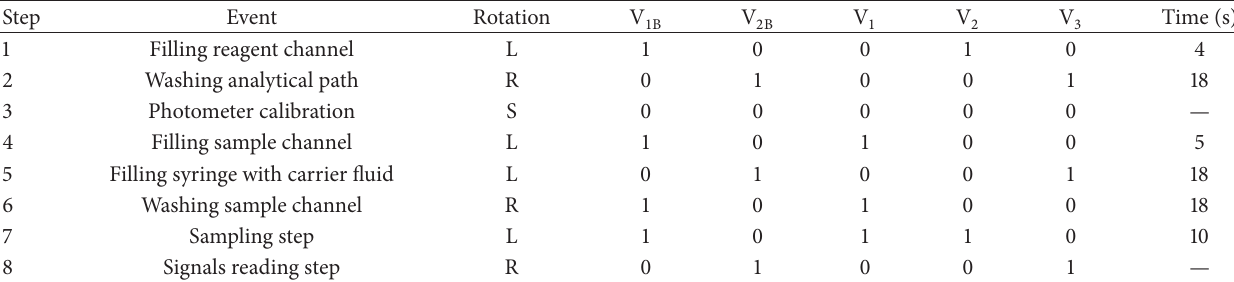
Table 1: Sequence of events related to an analytical